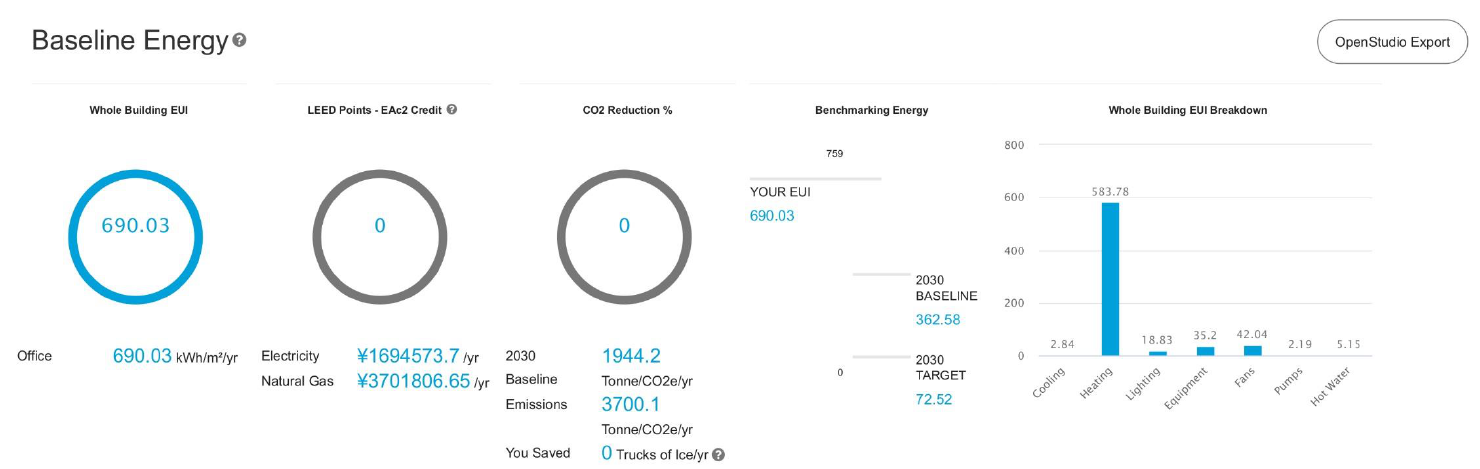
Clean Technol. 2022 , 4 , FOR PEER REVIEW Figure A31. Zone 6-A Changchun, Jilin (pre-COVID-19 scenario). Figure A31. Zone 6-A Changchun, Jilin (pre-COVID-19 scenario).